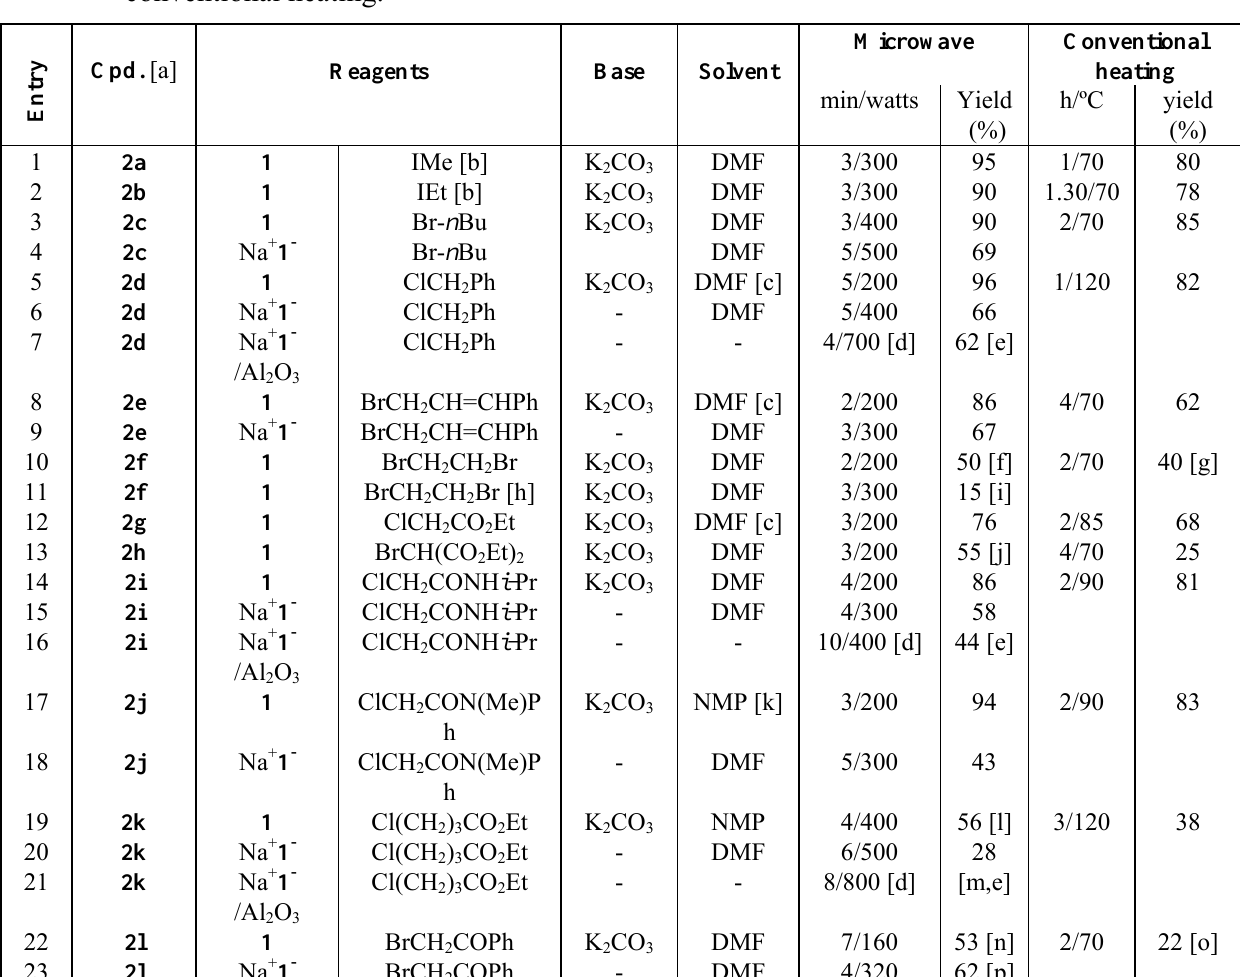
Table 2 . Reaction times and yields for isatin N -alkylation under MW irradiation and conventional